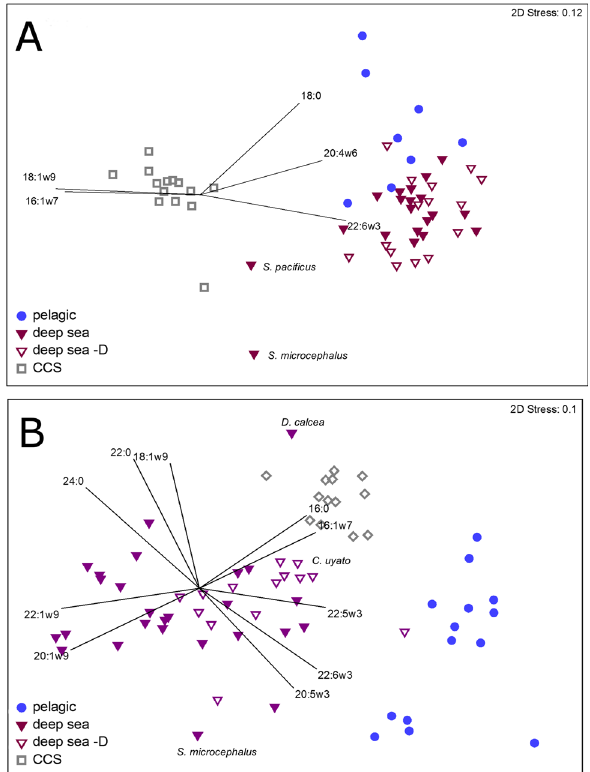
Figure 4. Non-metric MDS of ( A ) chondrichthyan muscle FA profiles (% contribution) and ( B ) liver FA profiles with vector overlays showing FAs with correlation values > 0.8. The results are displayed by habitat type (pelagic, deep sea, and deep sea demersal [indicated by –D], Appendix S1: Table S4), with the exception of the Cookiecutter sharks (CCS). S. pacificus: Somniosus pacificus, S. microcephalus: Somniosus microcephalus, D. calcea: Deania calcea, C. uyato: Centrophorus uyato .